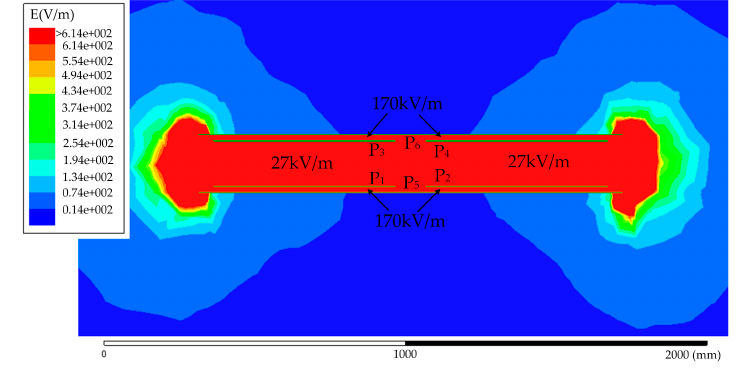
Figure 29. Electric field emissions of a 1.97 kW CPT system with six-plate capacitive coupler. According the IEEE C95.1 standard, the electric field strength should be lower than 614 V/m at